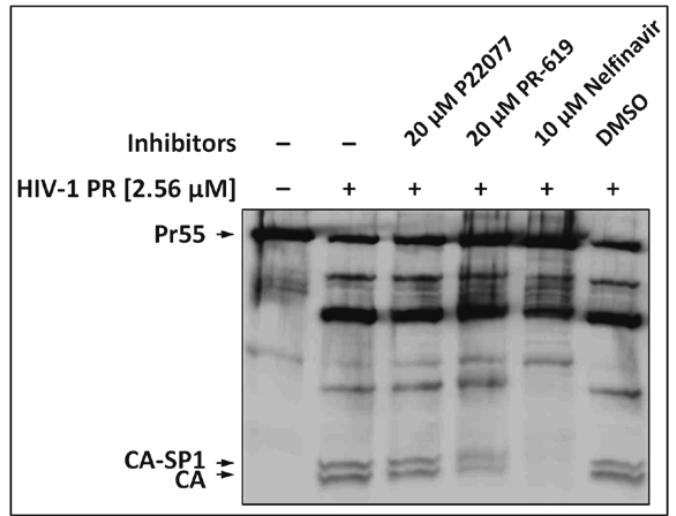
Figure 2. Effect of DIs on HIV-1 protease (PR) activity. HeLa cells were transiently transfected with p∆R PR − expression constructs. Pr55 Gag was obtained from released VLPs and incubated for 9 h with 2.56 μM of HIV-1 PR and 20 μM P22077 or PR-619. Treatment with 10 μM Nelfinavir or dimethyl sulfoxide (DMSO) served as positive or solvent controls, respectively.